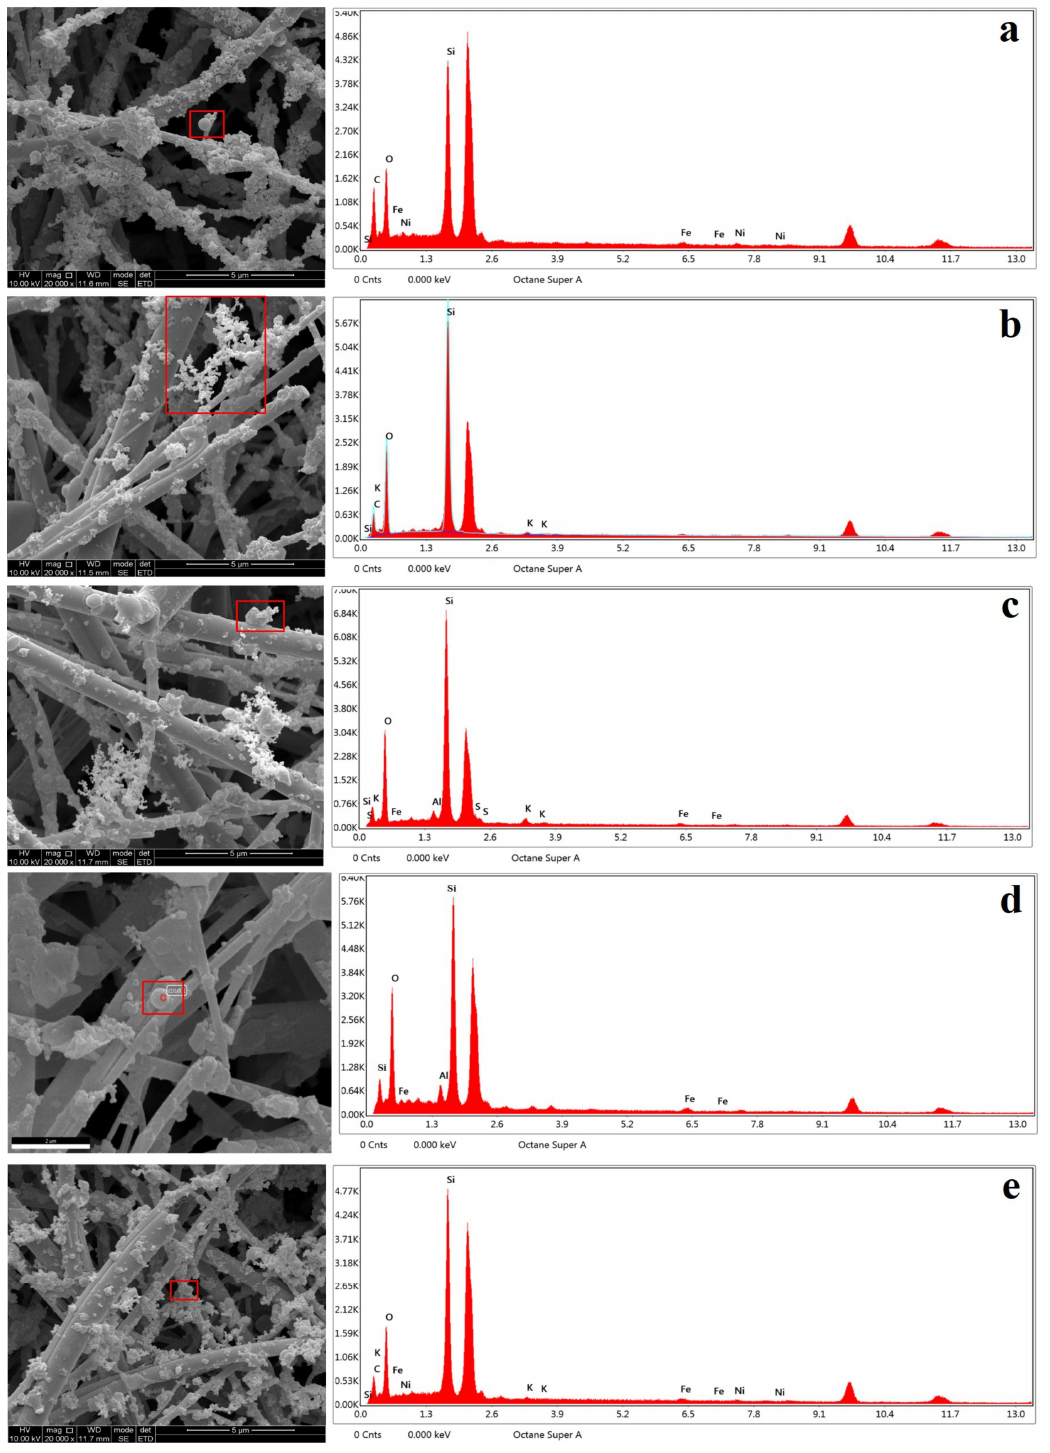
Figure 5. SEM micrograph and EDX spectrum of PM 1 . ( a ): fly ash, ( b ): soot, ( c ): sulphate particles, ( d ): aluminosilicate particles, ( e ): metal